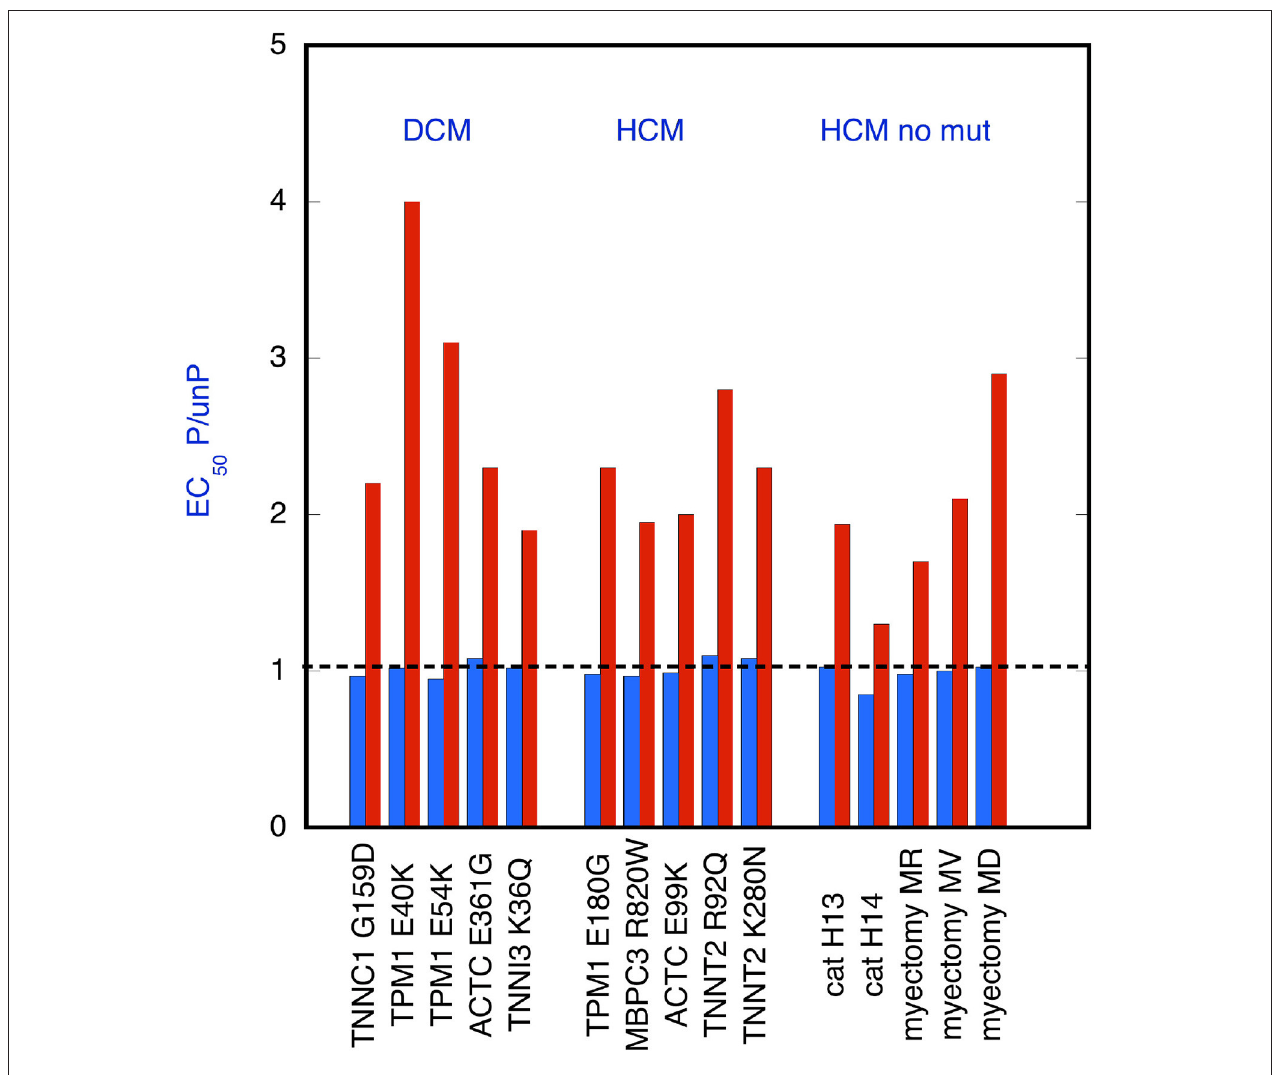
FIGURE 1 | EGCG recoupling of troponin. Ratio of EC 50 for phosphorylated and unphosphorylated thin filaments is plotted for thin filaments that are uncoupled. EC 50 was determined from Ca 2 + -concentration plots; see Figures 2A , 4A,C,D for examples. Raw EC 50 data is given in Table S1. EC 50 was measured by in vitro motility assay in the presence (red bars) and absence (blue bars) of 100 µ M EGCG. Mutant troponin or tropomyosin was from tissue (mouse, cat or human) with mutations in TnC (TNNC1), TnI (TNNI3), TnT (TNNT2), Actin (ACTC), tropomyosin (TPM1), myosin binding protein C (MYBPC3), and from cat heart with HCM and Human heart material from myectomy operations to relieve HCM; in the latter two cases samples were genotyped but no causative mutation was found. EGCG restored coupling to all the uncoupled systems. Includes data from (Papadaki et al., 2015; Messer et al., 2016,